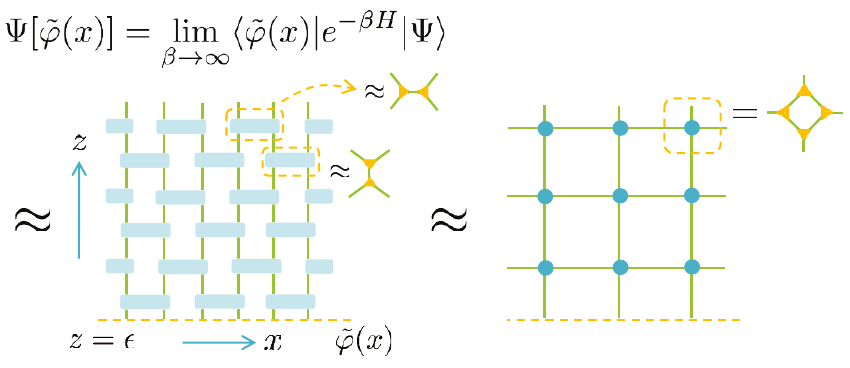
Figure 3 . The Euclidean path integral for the ground state wave functional (cid:9)[ ~ ’ ( x )] can be approximately described by a tensor network on a square lattice.